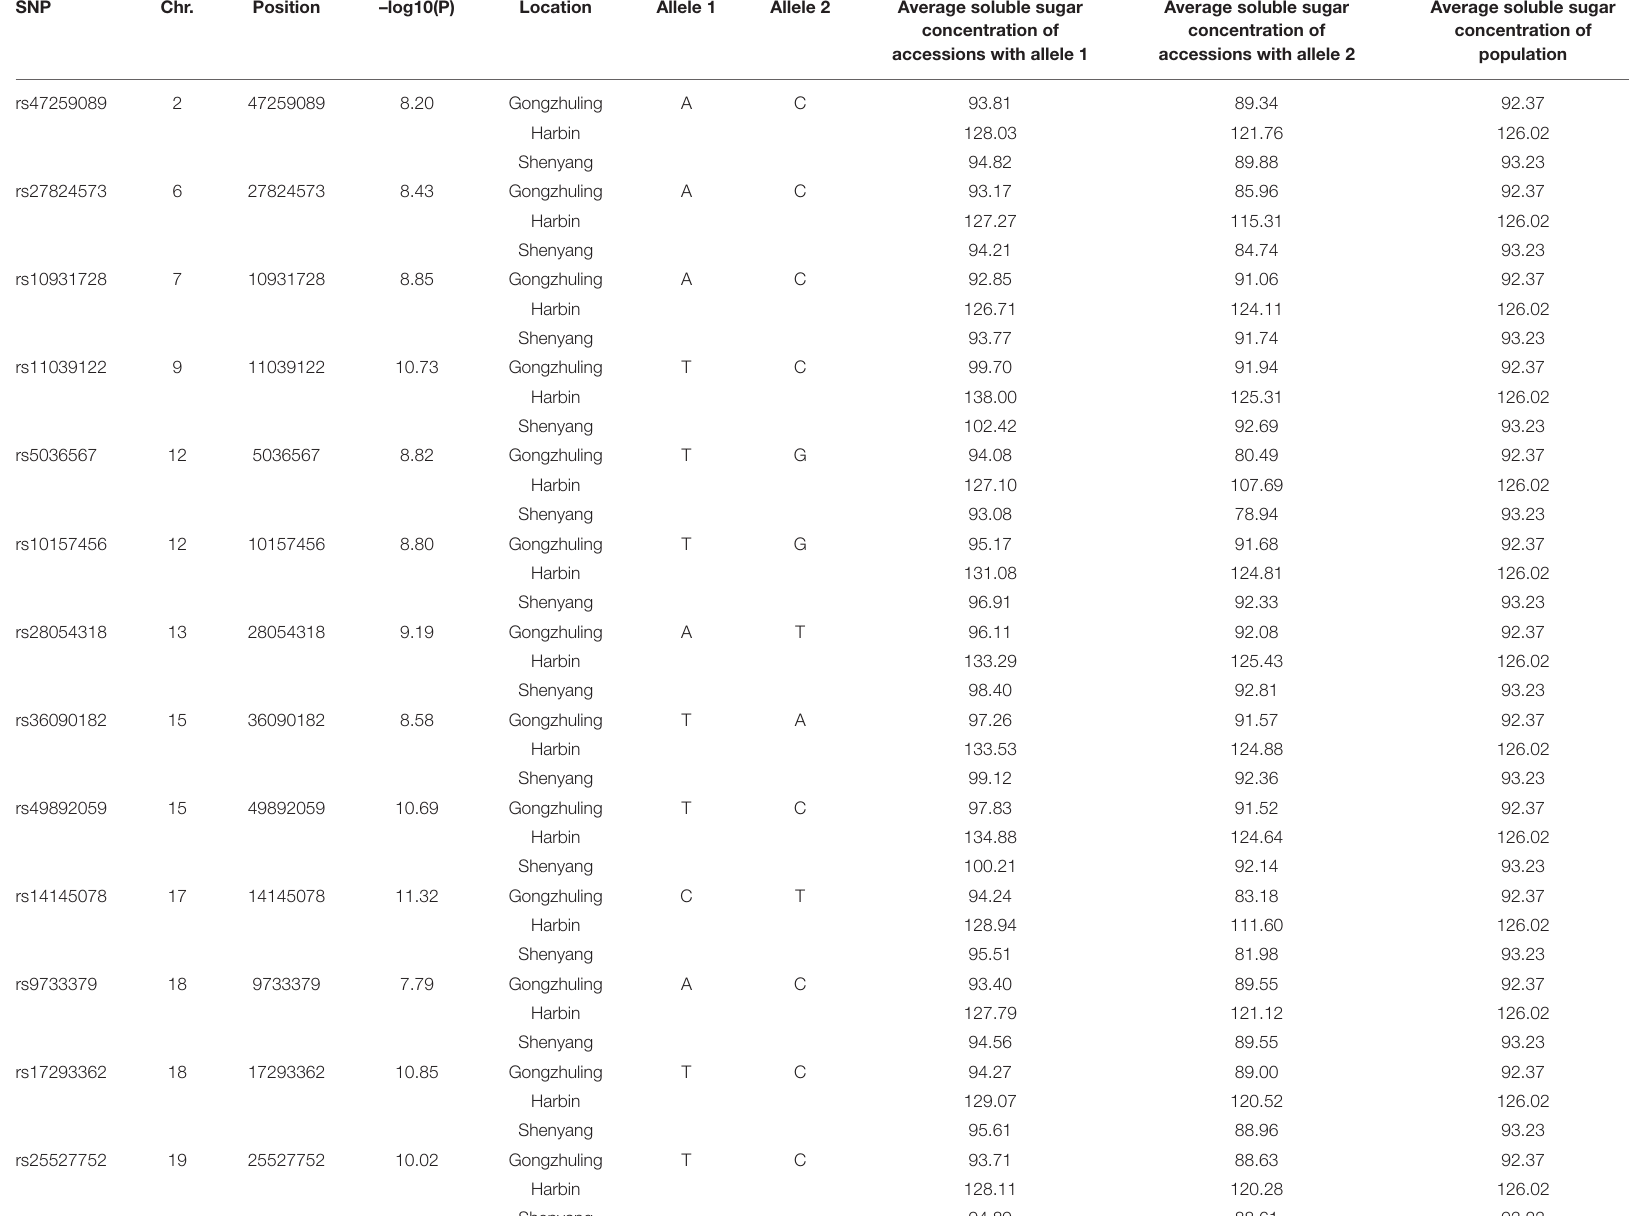
TABLE 2 | Peak SNP and beneficial allele associated with total soluble sugar content identified by GWAS. SNP Chr. Position –log10(P) Location Allele 1 Allele 2 Average soluble sugar